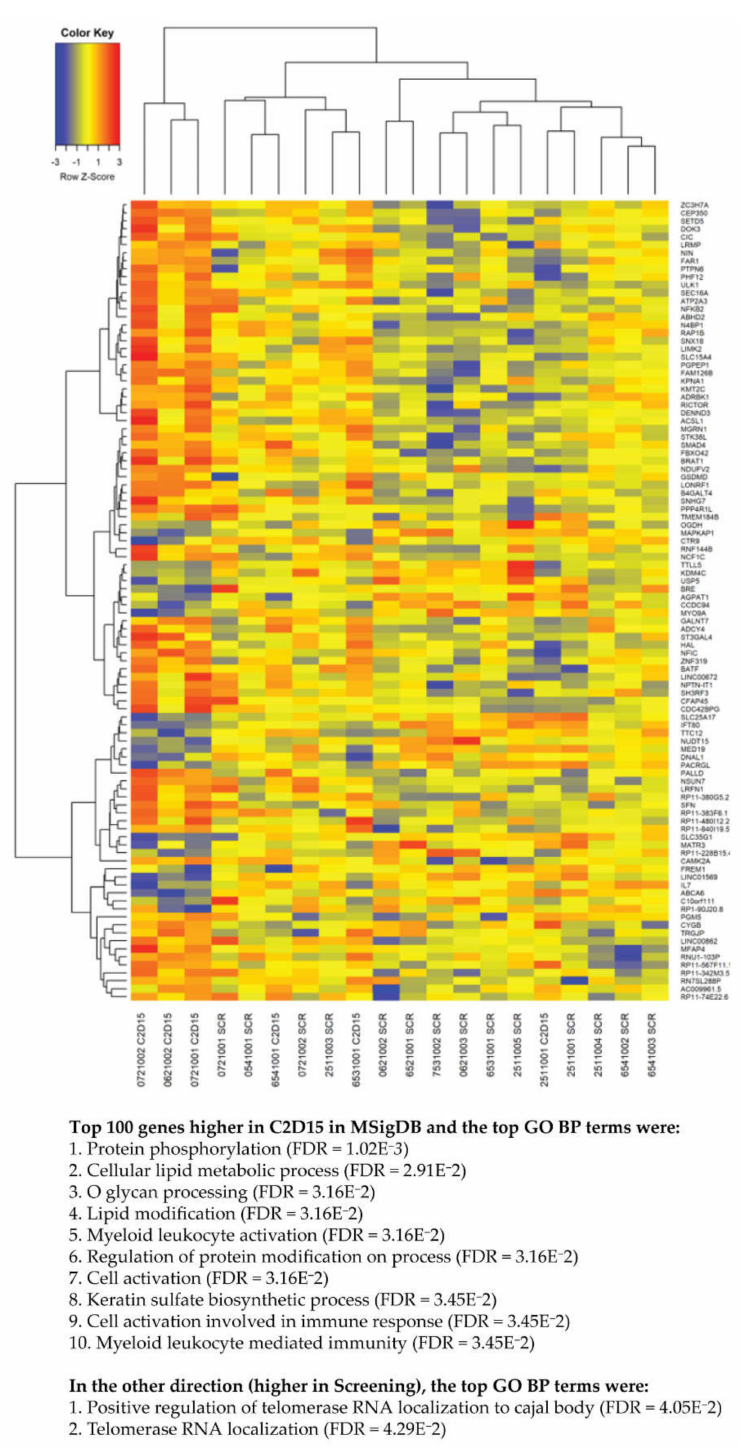
Figure 3. Comparison of the transcriptome of BM cells obtained at baseline and after initiation of daratumumab/durvalumab treatment. Shown are the top 100 differentially expressed genes between baseline samples ( n = 14) and those obtained after 6 weeks of daratumumab/durvalumab treatment ( n = 5). To perform gene set enrichment, the top genes were entered into the Broad’s MSigDB website, which computed the overlap with GO term gene sets. p -values were corrected for multiple testing by using the Benjamini-Hochberg false discovery rate (FDR)